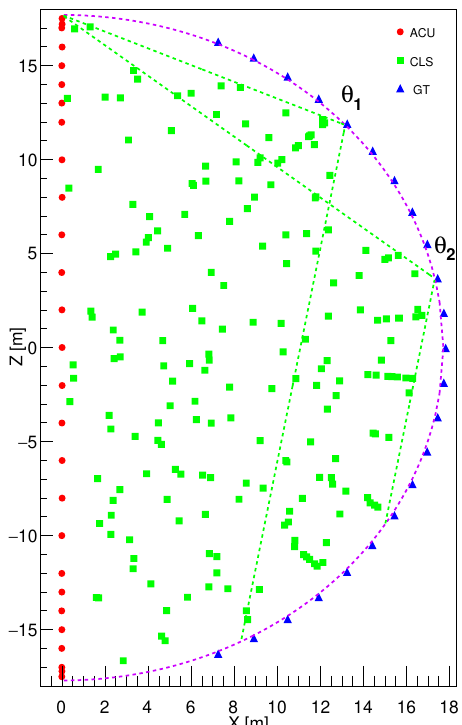
Figure 12 . The optimized 250 calibration points in a half vertical plane of the JUNO CD, based on the procedure in the text. The purple dashed line represents the acrylic boundary. The ACU, CLS and GT are individual source deployment systems discussed later in section 4. The green dashed lines are the assumed boundaries of the